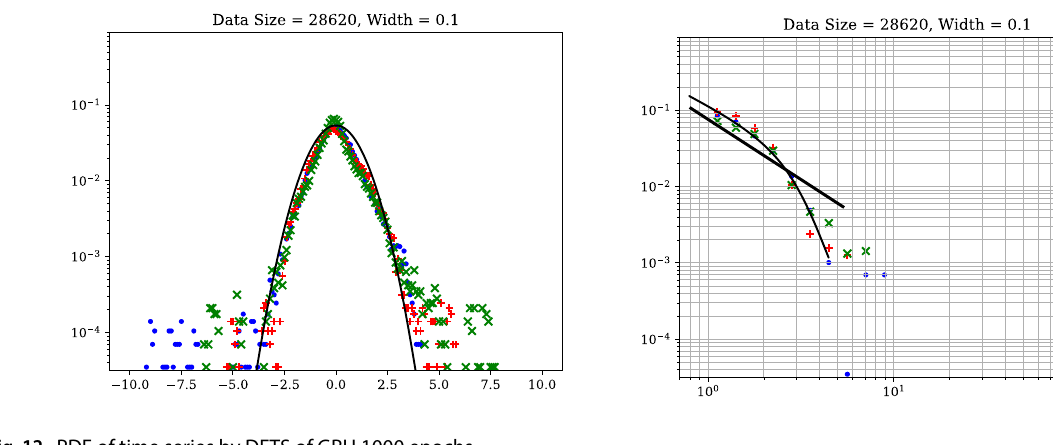
Fig. 12 PDF of time series by DFTS of GRU 1000 epochs